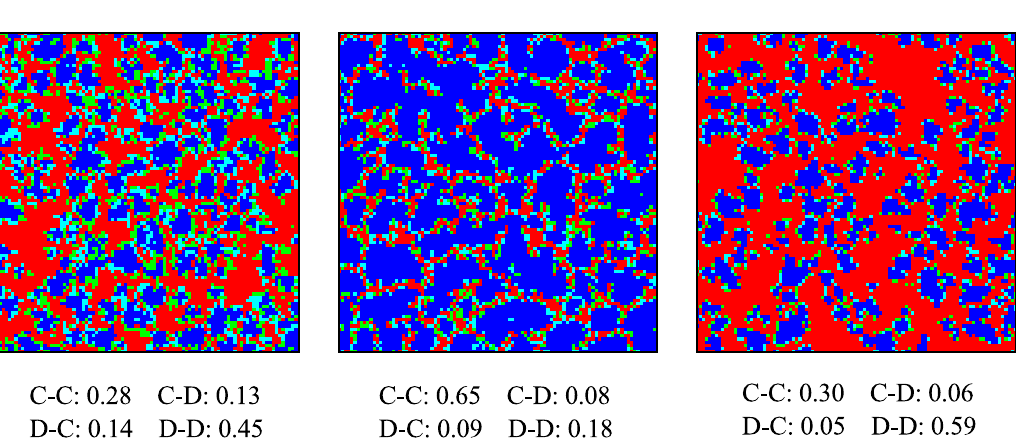
Figure 3. Stable spatial distribution of strategies couple for u = 0.1 (left panel), 0.2 (middle panel), 0.6 (right panel). C–C, C–D, D–C and D–D couples are colored in blue, green, light blue and red, where a C–D couple means that the player on layer A chooses cooperation and his partner on layer B chooses defection, and